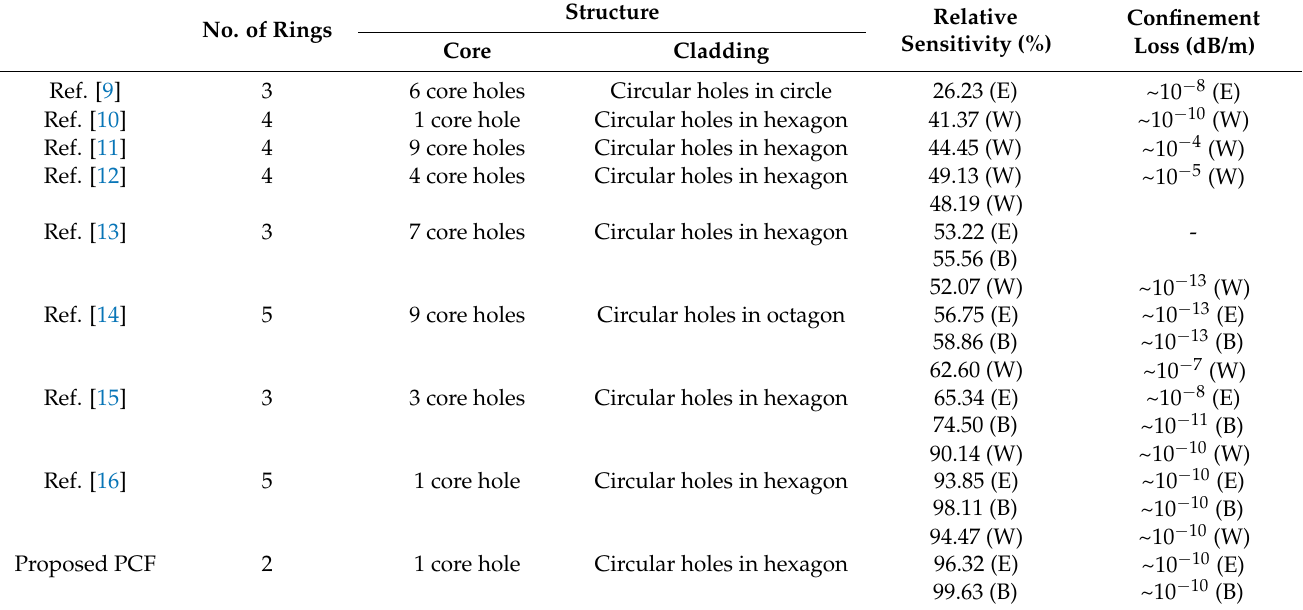
Table 2. Comparison of structure and performance among prior PCFs and proposed PCF at λ = 1.3 µ m. No. of